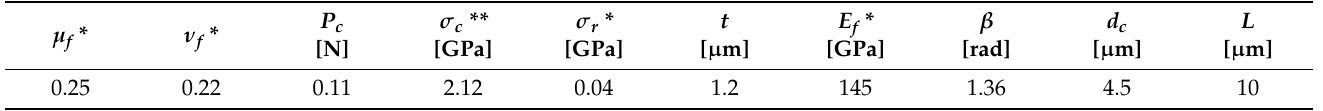
Table 2. Parameters used for the calculation of adhesion